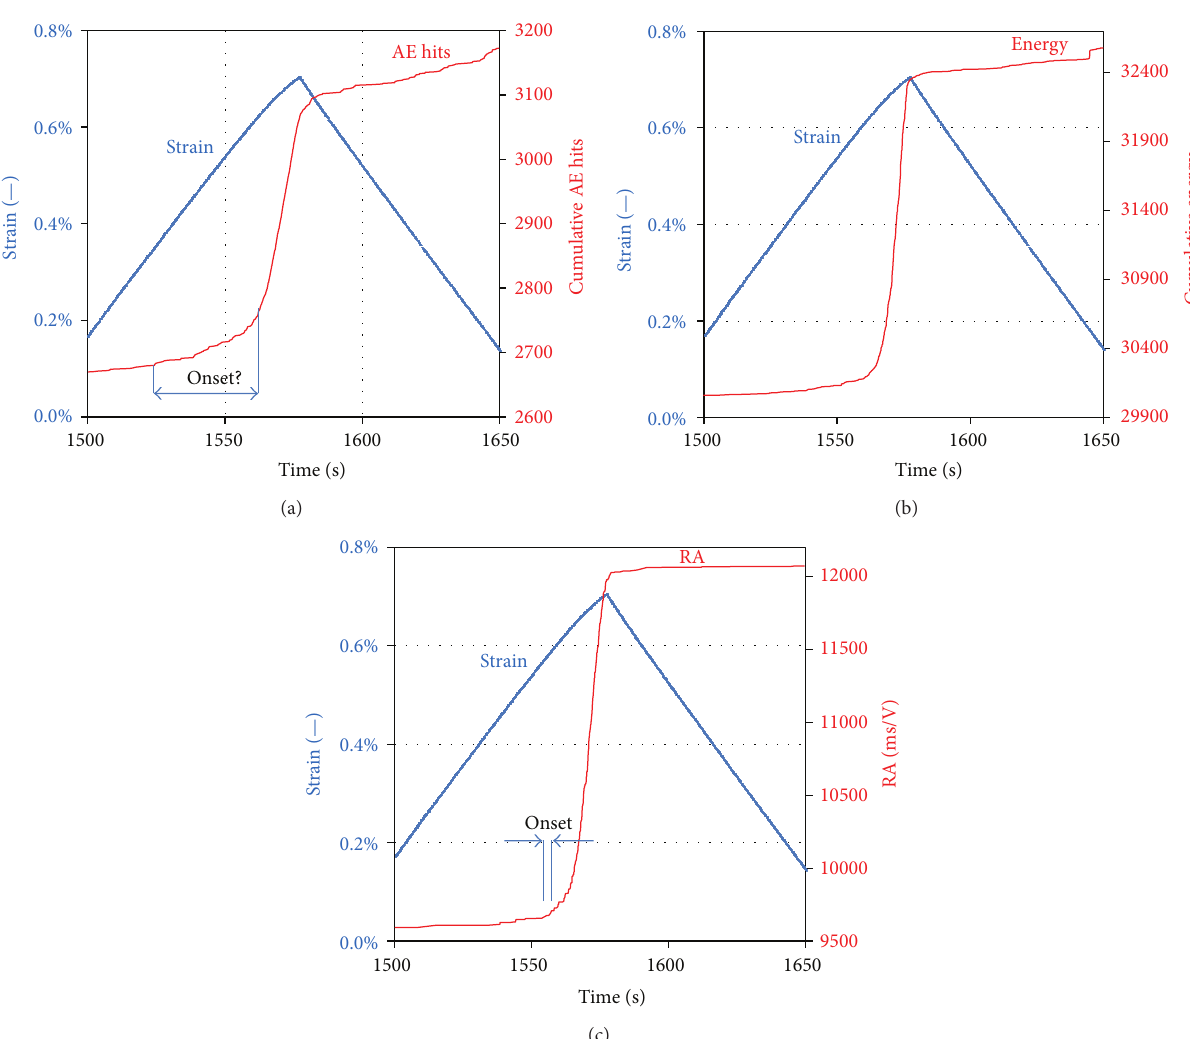
the negative peak where the material is under negative